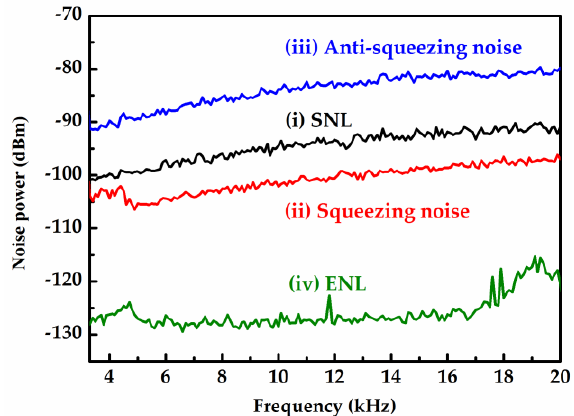
Figure 7. Measured noise power of the generated phase squeeze vacuum states at audio-band frequencies from 3.5 kHz to 20 kHz: Curves (i)–(iv), SNL, squeezing noise, anti-squeezing noise and ENL, respectively. The parameters of SA: RBW of 50 Hz, VBW of 100 Hz and sweep time of 1 s. All noise power traces were averaged 20 times.